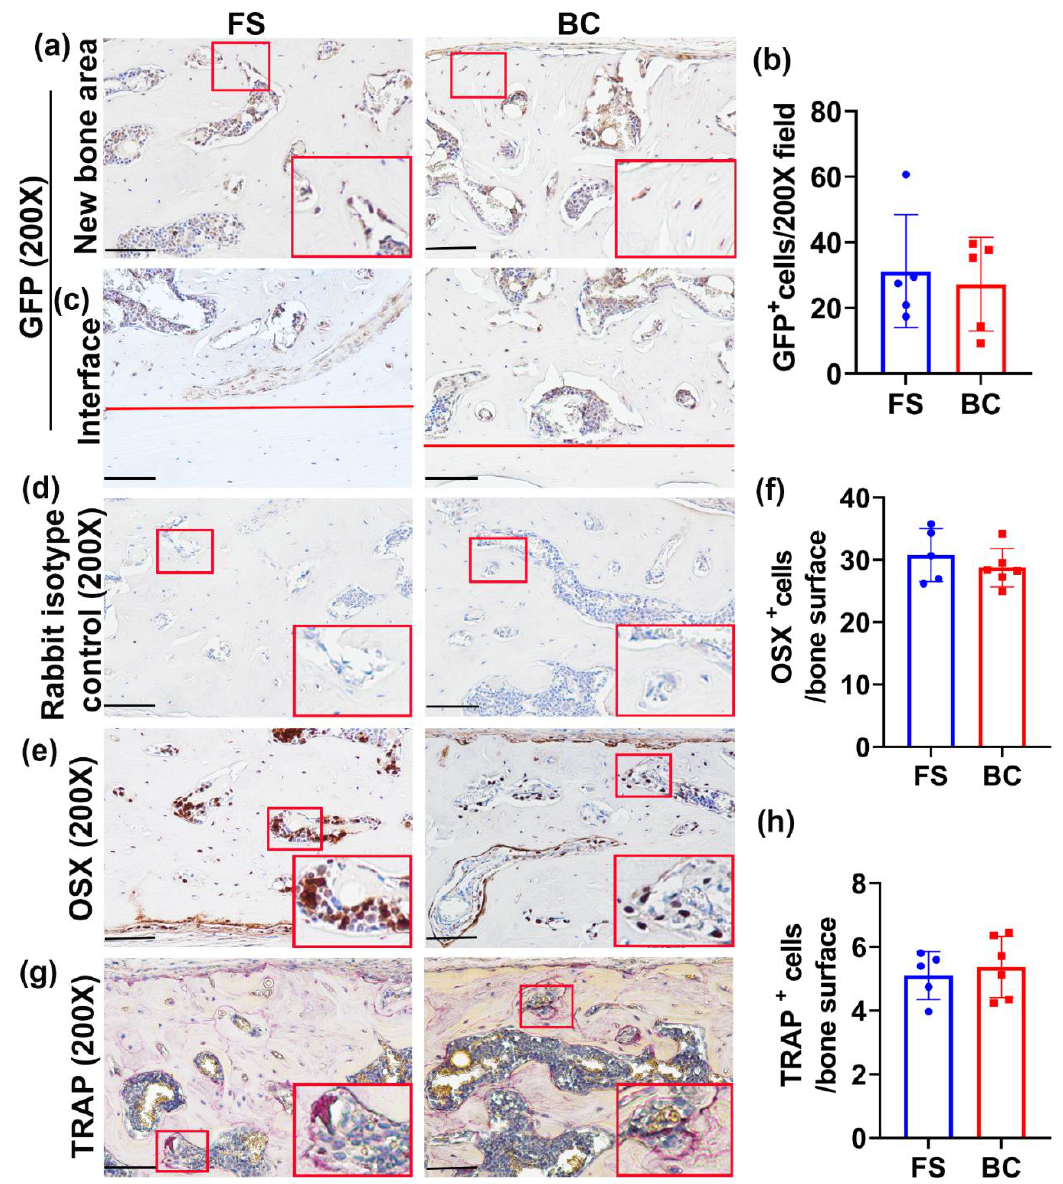
Figure 5. Histology staining of GFP donor cells and bone cells. ( a ) Immunohistochemistry of GFP for donor cells’ contri- bution to the regenerated bone. GFP + cells showed in brown color on bone surface or in bone area. Few GFP + cells were